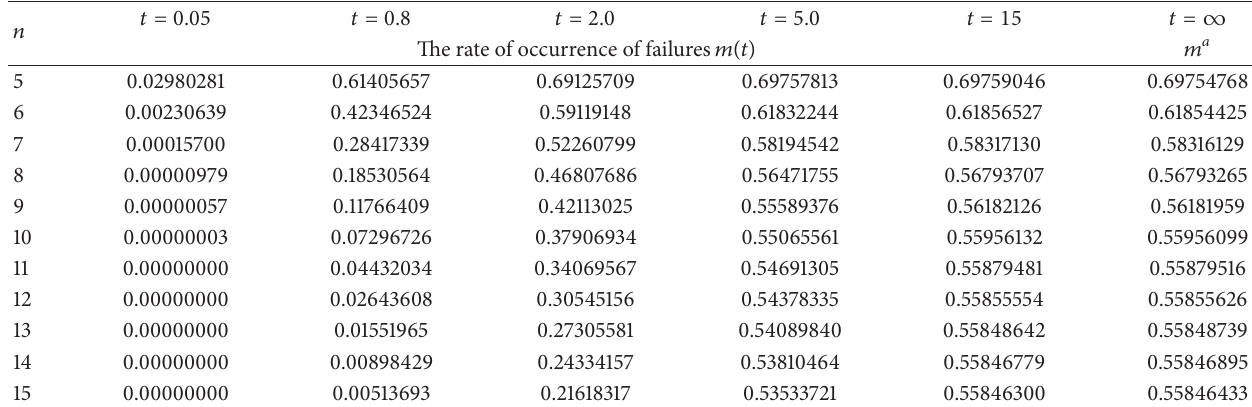
Table 6: The rate of occurrence of failures for different values of 𝑛